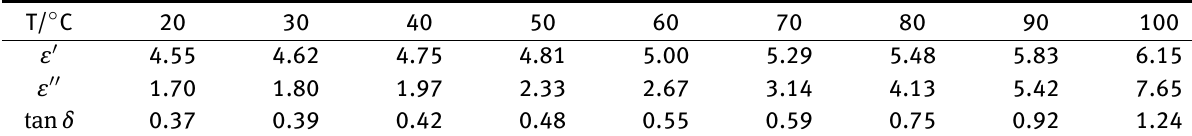
Table 1: Dielectric parameters of aqueous 4% sodium chloride at 2.45 GHz [24]